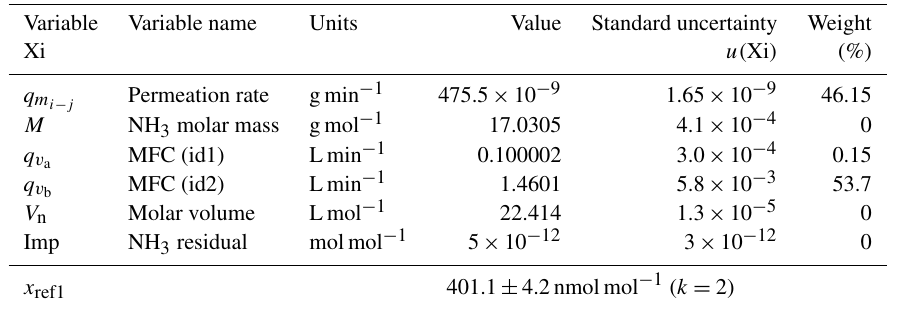
Table 2. The uncertainty budget of the amount-of-substance fraction of one of the ammonia RGMs generated after the first dilution stage. The contribution, in percent, of each variable to the overall uncertainty is indicated in the weight column. The last row shows the amount-of- substance fraction value and its expanded uncertainty. k is the coverage factor of the uncertainty.